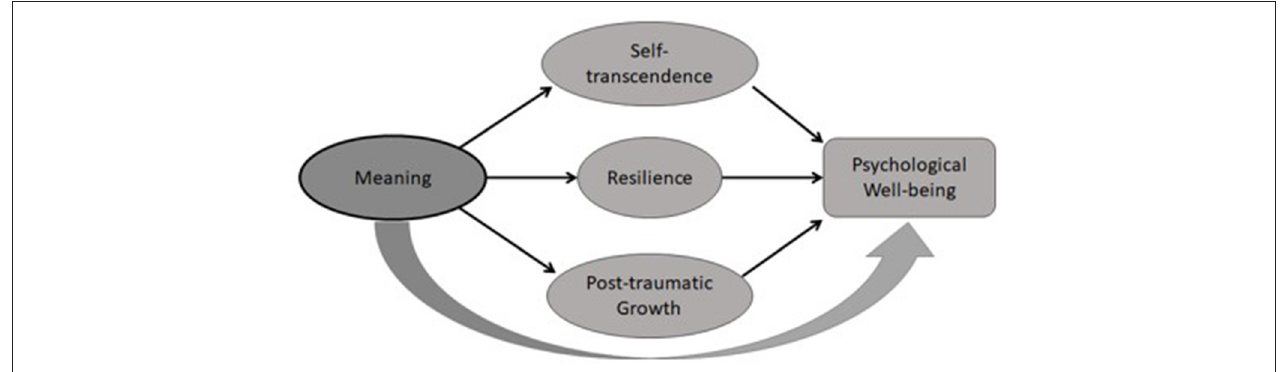
FIGURE 1 | Logotherapy-based model of self-transcendence: meaning as